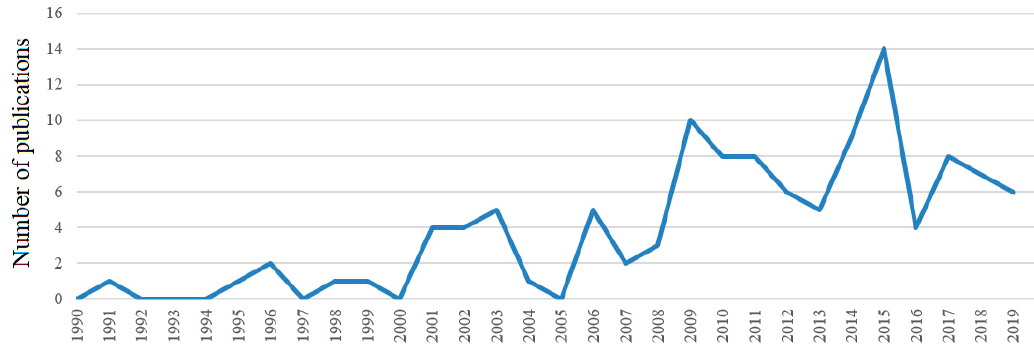
Figure 1. Growth in published papers on employee creativity.